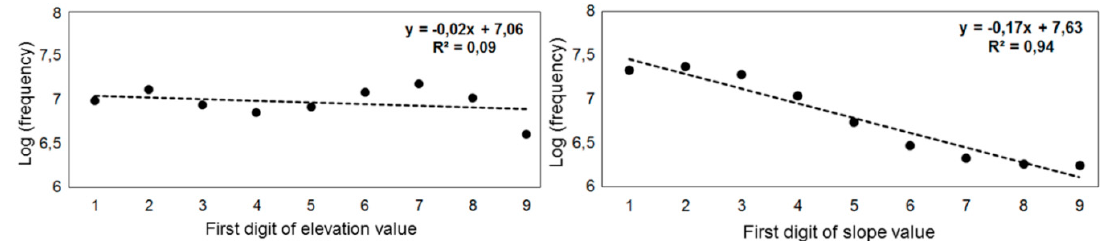
Figure 11. Control of the compliance of a DEM with Benford’s law for two metrics: elevation and slope (source: [125]).